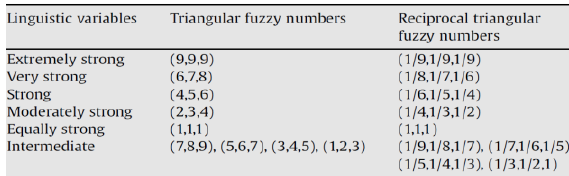
Figure 5. Triangular fuzzy numbers of linguistic variables used in this